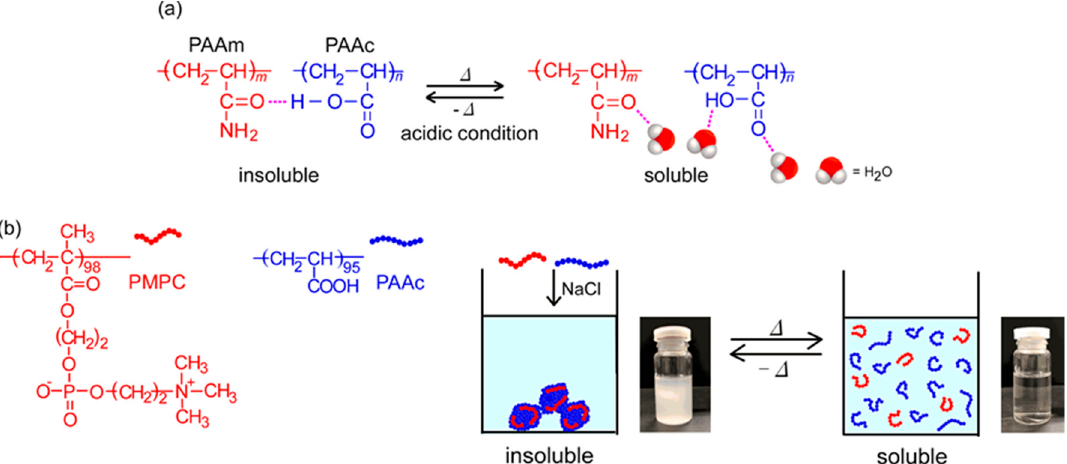
Figure 1. ( a ) Complex formation of poly(acrylamide) (PAAm) and poly(acrylic acid) (PAAc) owing to hydrogen bonding interactions, and the dissociation of aggregates upon heating; and ( b ) conceptual illustration of the UCST behavior of the mixed aqueous solutions of poly(2-methacryloyloxyethyl phosphorylcholine) (PMPC) and PAAc.